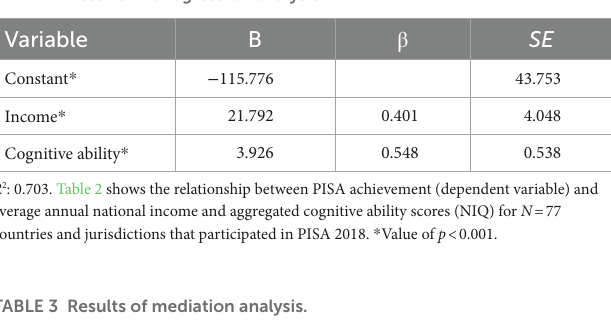
TABLE 3 Results of mediation analysis. Mediator